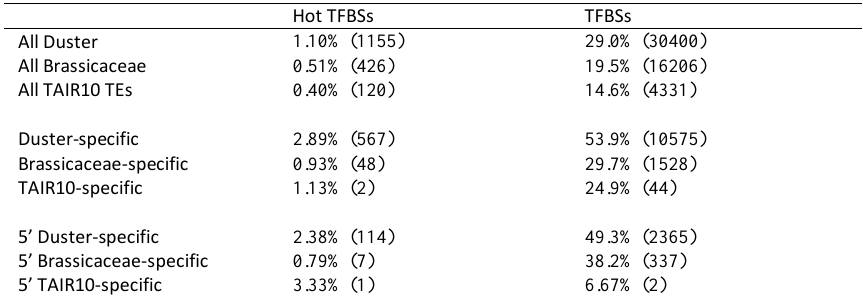
Table 4: Method-specific TEs overlap with TFBS identified by ChIPseq. Occurrences are given between